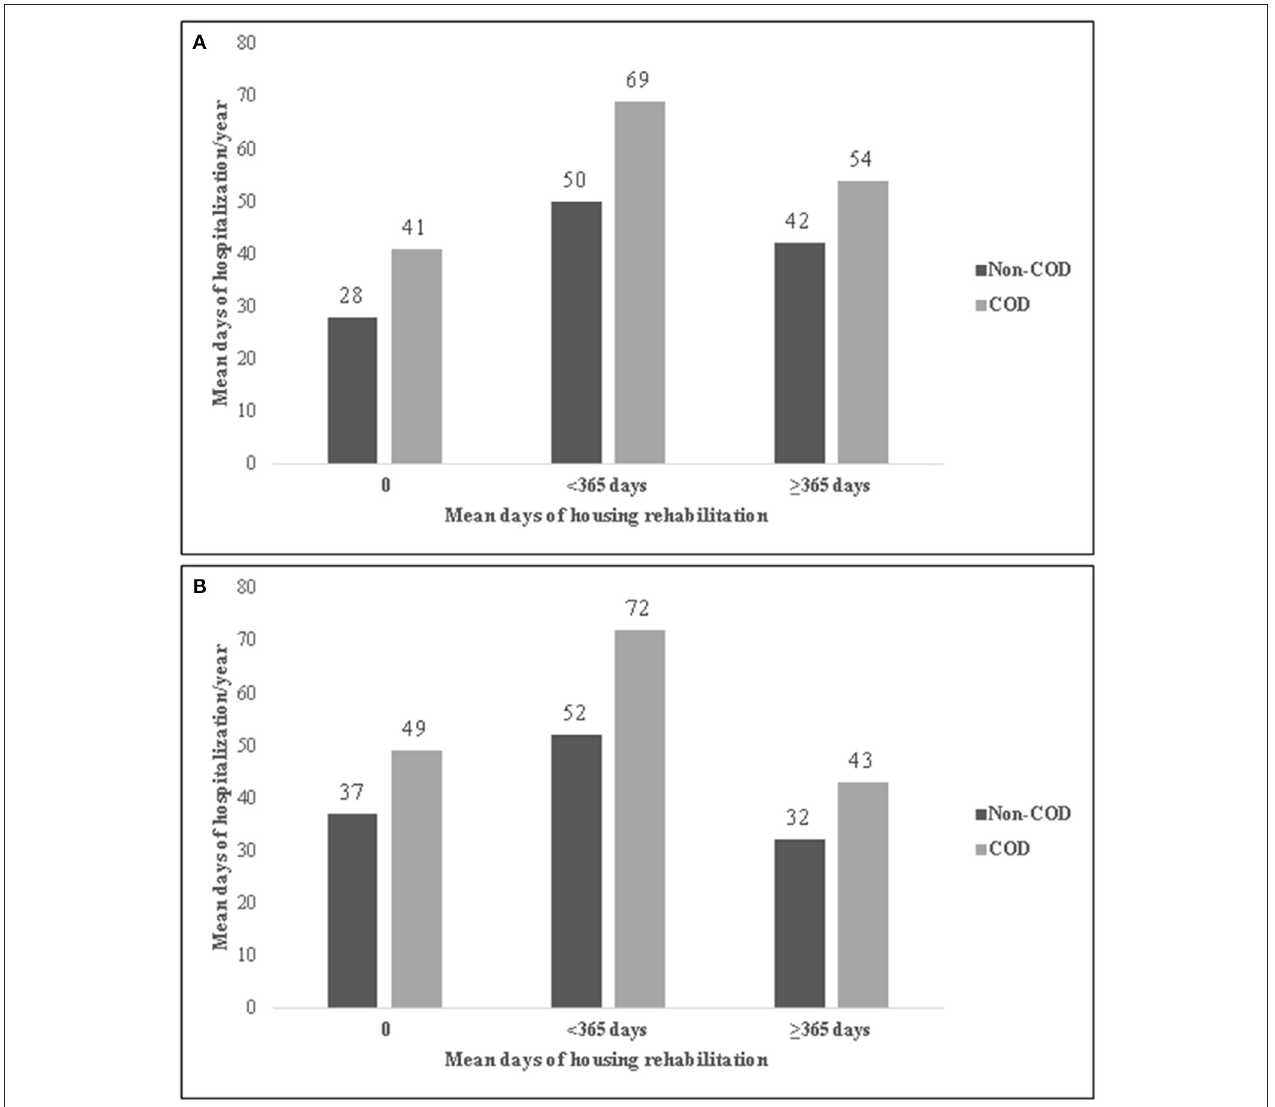
FIGURE 1 | Mean psychiatric hospitalization days per year by duration of housing rehabilitation in Period 1 (2001–2009) (A) and Period 2 (2010–2016) (B) , among hospitalized persons with co-occurring disorders (COD) of chronic psychotic disorder and SUD, Israel, 2010–2016. (A) Period 1 . (B) Period 2